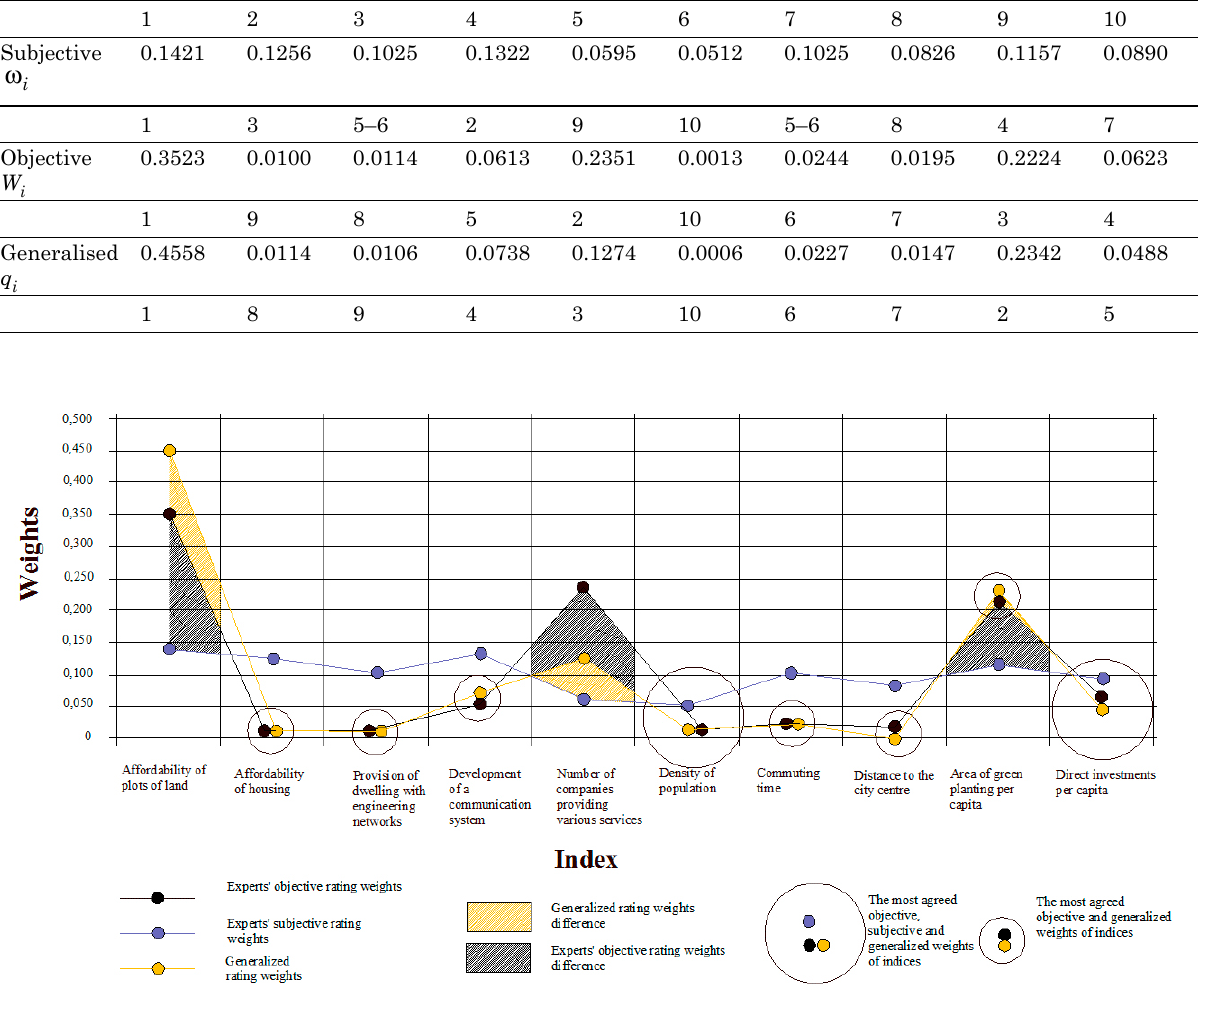
Fig. 2. Differences between comparative weights of